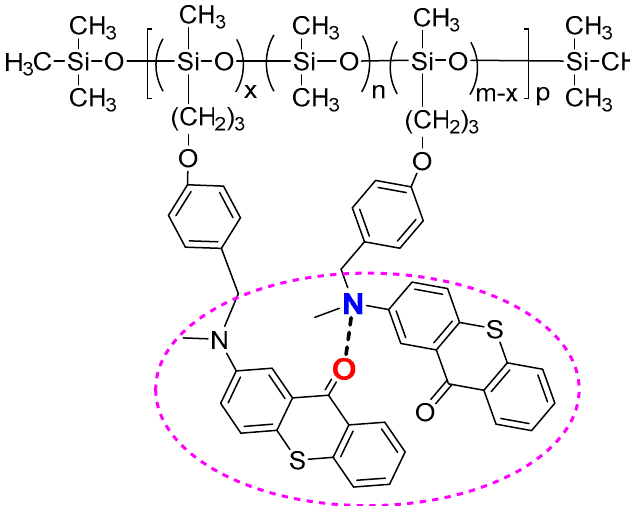
Chart 2. The molecular synergistic effect in the STX system.